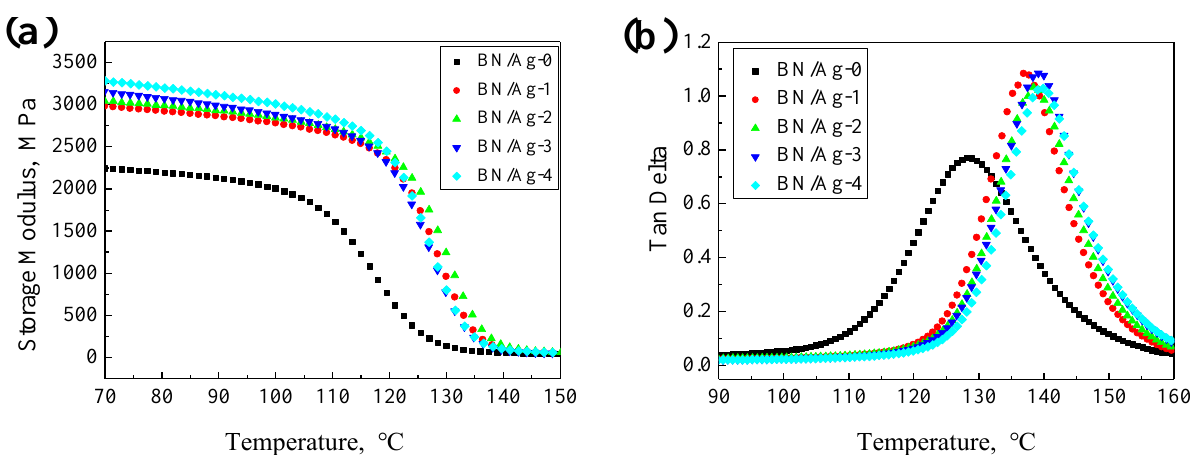
Figure 4. ( a ) Storage modulus of Composites ( b ) Loss tangent of Composites. The bending strength of the BN/AgNWs/EP composites with different filler mass ratios is shown in Figure 5. Here, one could see that, as the content of AgNWs in the composite fillers increased, the bending strength of the composites declined. Combined with Table 2, it can be seen that the addition of BN will cause the mechanical properties of BN/EP to be lower than that of EP, while coupling agent and DA can improve the interfacial compatibility and improve the mechanical properties of composites. Based on the principle of hydrolyzation by KH550, which brings the amino group to the surface of BN, the interface compatibility between BN and epoxy resin improves. Similarly, under PDA coating, AgNWs and epoxy have better interface compatibility. Therefore, the downward trend of bending strength becomes weaker. However, due to their high aspect ratio, AgNWs are more prone to breakage under external force. As a result of the destruction of the integral structure of the epoxy resin matrix, the matrix develops an increased number of defect sites. A composite with a higher content of AgNWs in the composite filler will therefore have a weaker bending strength.